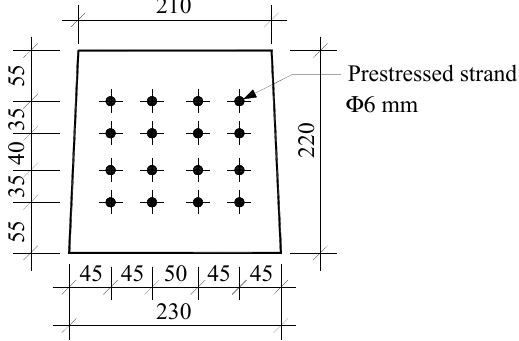
Figure 2. Cross-section of the bearer (dimensions are in millimetres).